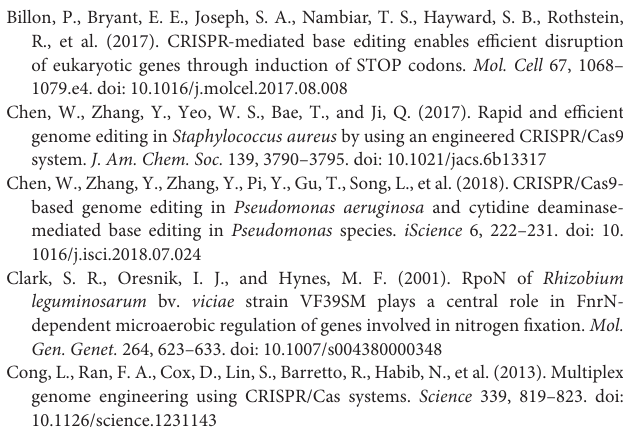
Supplementary Figure 2 | Editing window of CBE systems in S. meliloti . The editing windows of the CBE2 system were compared by analyzing various guide RNAs harboring Cs at different positions of the protospacer. P1–P8, P12, and P15 indicate the position of C(s) in the protospacer. The protospacer adjacent motif (PAM) is located at positions 21–23. The representative sequencing chromatogram for each target locus and the calculated editing efficiencies are shown. Supplementary Figure 3 | Editing window of GBE systems in S. meliloti . (A) Schematic diagram of a unique cytidine base editor (CBE). This CBE lacks the Uracil DNA glycosylase inhibitor (UGI) element at the C-terminus of the SpCas9 nickase (Cas9n D10A) that could promote the catalysis of C-to-G transversions. A representative sequencing chromatogram for the target nodA is shown (B) . (C–F) Representative sequencing chromatograms and the calculated editing efficiencies for each target locus. P2–P8 indicates the position of C(s) in the protospacer. The protospacer adjacent motif (PAM) is located at positions 21–23. Supplementary Figure 4 | SacB -based plasmid curing after gene editing. (A) Schematic flowchart for plasmid curing. Strains containing the sacB plasmid were first analyzed for targeted gene mutations. The mutants were grown in a liquid TY medium without antibiotics. Strains that lost plasmids were selected on solid TY medium containing sucrose. The plasmid-free cells are suitable for the next cycle of gene manipulation. (B) Three independent mutant strains with nodA mutated by an ABE system. The sequencing chromatographs of PCR products are oriented from 5’ to 3’. (C) Selection of colonies after plasmid curing. Two individual colonies from each strain were selected from a solid TY/sucrose medium. The antibiotic sensitivity was assayed. No growth was observed in the presence of neomycin. Supplementary Table 1 | Off-target analysis of ABE in S. meliloti. Supplementary Table 2 | Off-target analysis of CBE in S. meliloti. Supplementary Table 3 | Primers used in this study. Supplementary Table 4 | DNA sequences used in this